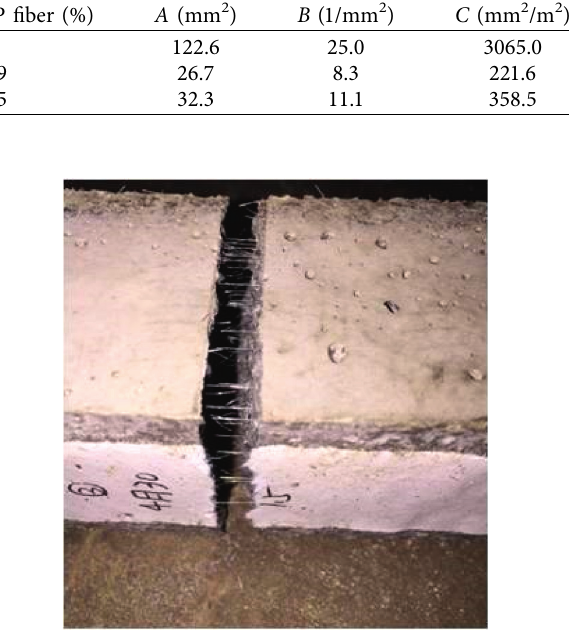
Figure 5: Flexural fracture of CGA mortar.